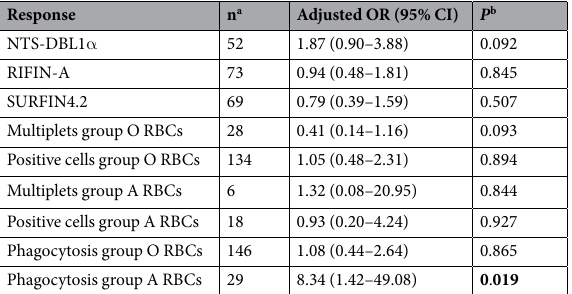
RBCs, 16% of the mild samples and 6% of the complicated samples were positive (Table S1). There was no signif- icant difference in the percentage of multiplets when samples belonging to mild, complicated or Swedish controls were compared, (Fig. 2B lower panel), in contrast to the difference observed when the samples were tested on parasites grown in group O RBCs. When the association between surface reactivity and rosetting rate was assessed, a low negative correlation (r = − 0.299, p < 0.0001 for group O and r = − 0.350, p = 0.017 for group A) was observed between the two varia- bles (Fig. S2), irrespectively of the blood group used to grow the parasites tested, with increasing levels of surface reactivity associated with lower rosetting rate. When association between rosetting rate and the IgG levels against the three proteins was assessed, only low negative (r = − 0.157, p = 0.037 and r = − 0.324, p < 0.0001) correlations were observed with anti NTS-DBL1 and SURFIN 4.2 IgG levels respectively (Fig. S3) when rosetting rate was measured on parasites grown in group O RBCs; suggesting an association between IgG levels for these antigens and the rosetting rate, with increasing levels of IgG generating lower levels of rosetting.